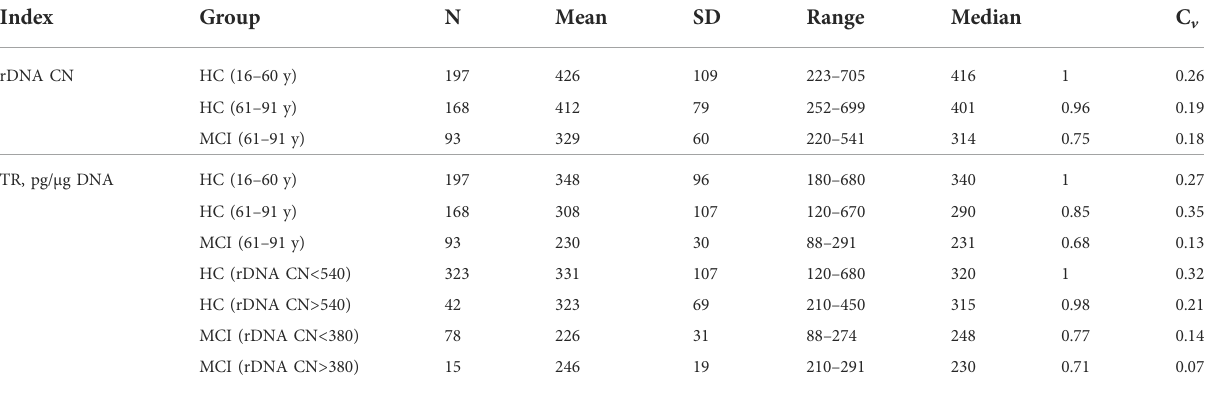
TABLE 2 Descriptive statistics data for rDNA CN and TR content in